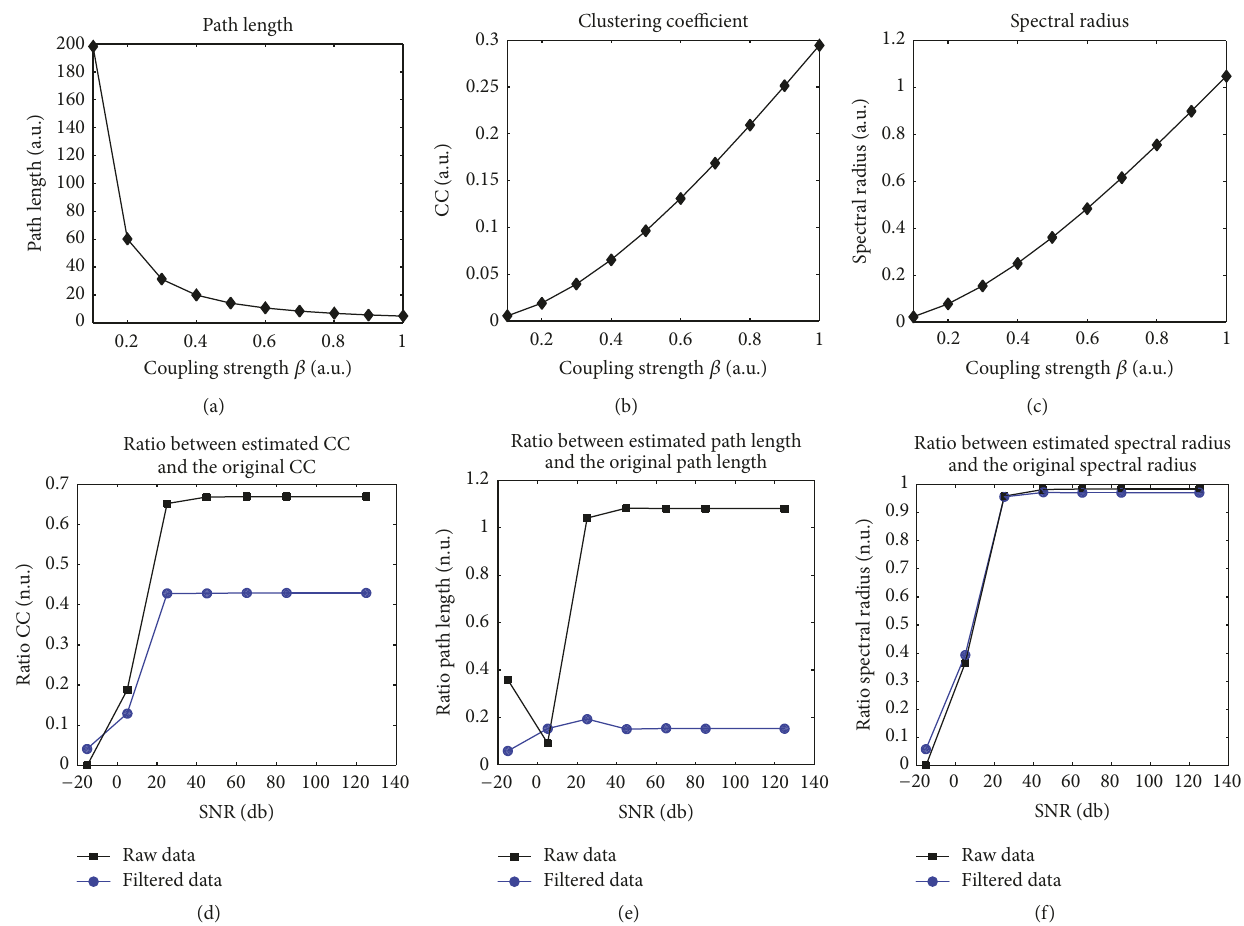
Figure 2: The figure shows the results for the simulation dataset. (a, b, c) show how the graph indices behave for different level of coupling in model (1). (d, e, f) investigate how the transfer entropy can estimate the network indices for different level of SNR. In particular, the figure compares the two cases when the data is filtered and when the raw data is